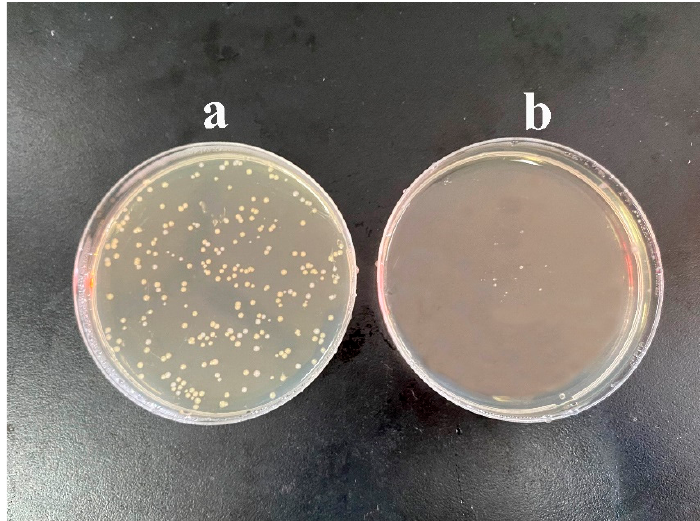
Figure 11. Agar medium inoculated with Staphylococcus aureus for 24 h (( a ) SA/R-0 bacterial suspension, ( b ) SA/R-2 bacterial suspension)).